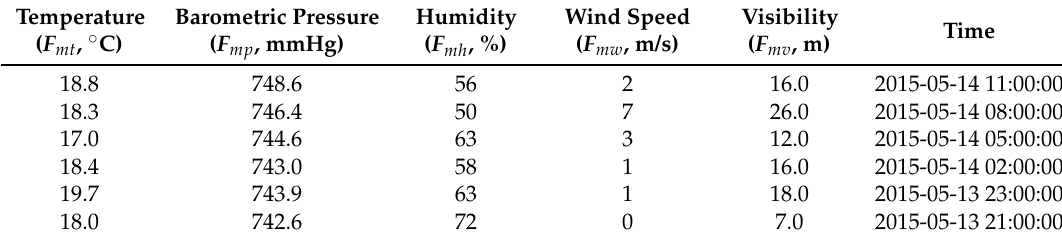
Table 5. Meteorological